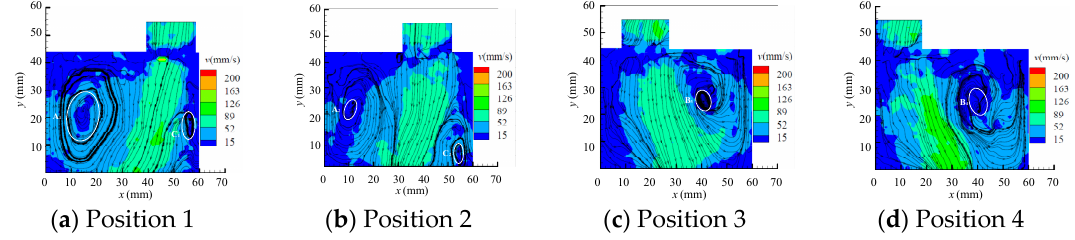
Figure 19. Velocity contours and streamlines with a piston moving speed of 12.5 mm/s.